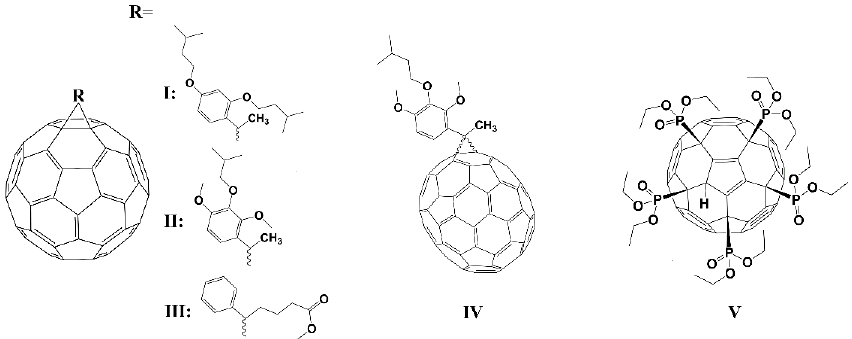
Figure 1. The molecular structure of compounds I – V